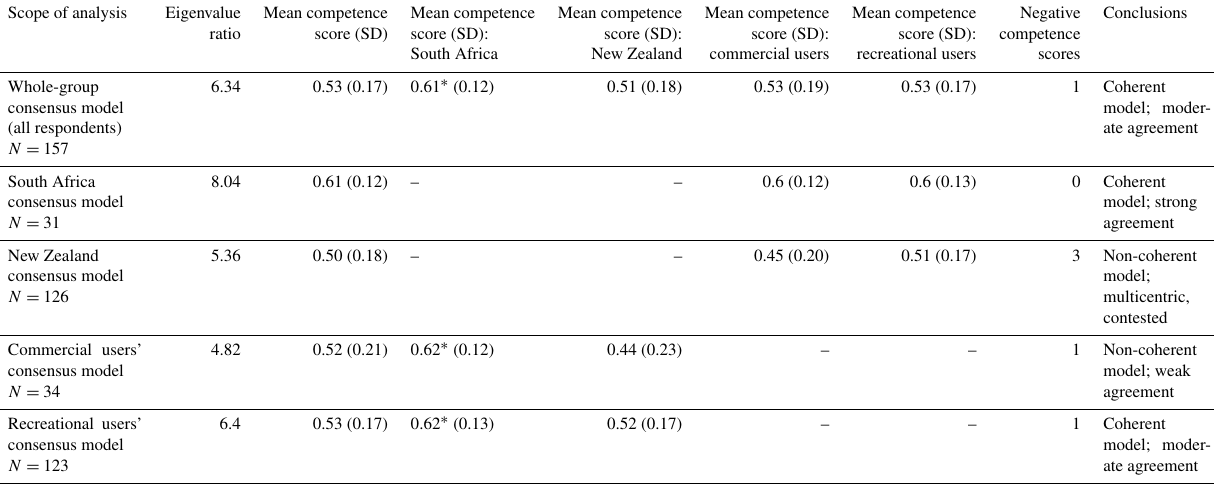
Table 1. Cultural consensus analysis, group mean competence scores and eigenvalue ratios of the first to second factors for each study region and sector. An individual’s competence score is the probability that the informant knows (not guesses) the answer to a question, and it is a value between 0 and 1. A group’s average estimated competence score above 0.5 indicates moderate agreement in the group, pointing to an underlying model of shared knowledge. Five consensus models were calculated (column 1); for each consensus model, the breakdown of mean competence scores along group membership is shown for comparison. Conclusions regarding the consensus model are based on criteria by Caulkins and Hyatt (1999). Here, SD refers to the standard